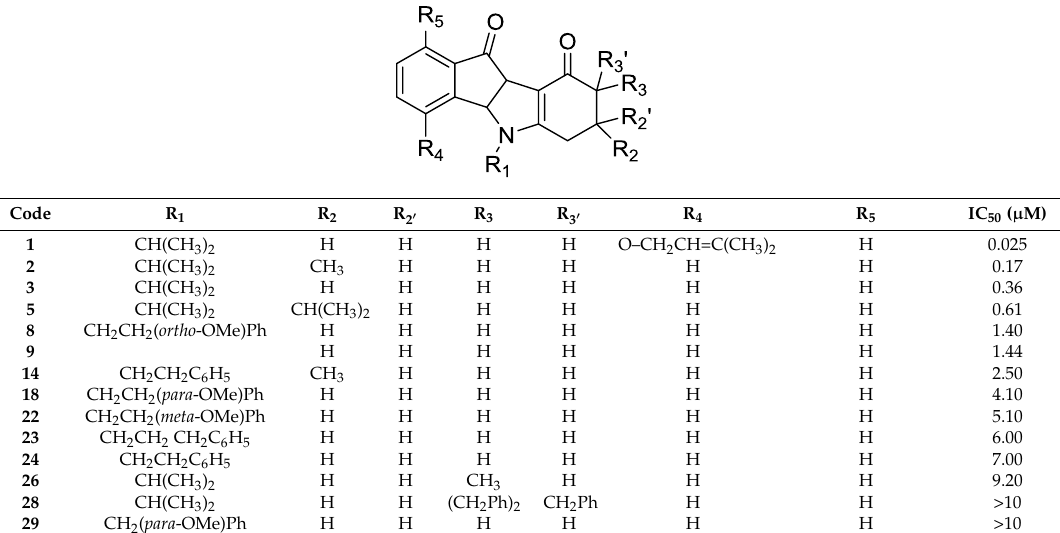
Table 1. Structures of the ketonic indeno[1,2- b ]indoles and their IC 50 values towards CK2, which were used for the training and test sets, data from Alchab et al. [9] and Gozzi et al. [13]